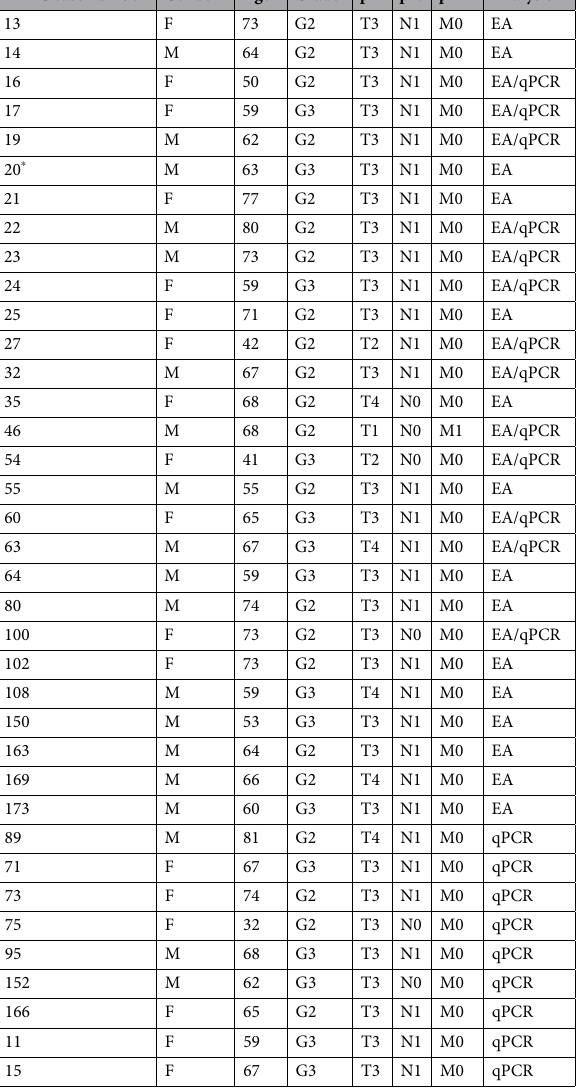
Table 1. Demographic and clinical information of the analysed PDAC samples. * This sample was derived from the patient that received neoadjuvant therapy (Gemcitabine + Oxaliplatin; all the remaining samples were obtained from naive patients. EA = exon array; qPCR = quantitative polymerase chain reaction; pTNM (pathology staging: Tumour, lymph Nodes,